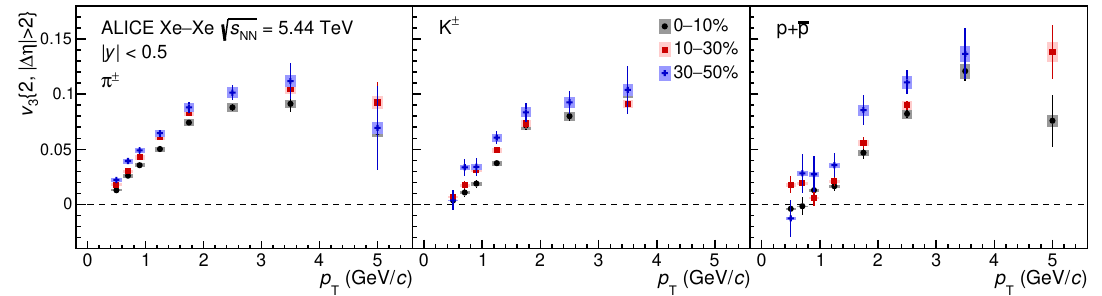
Figure 3. Centrality dependence of v 3 ( p T ) for π ± , K ± , and p+ p . Bars (boxes) denote statistical (systematic)